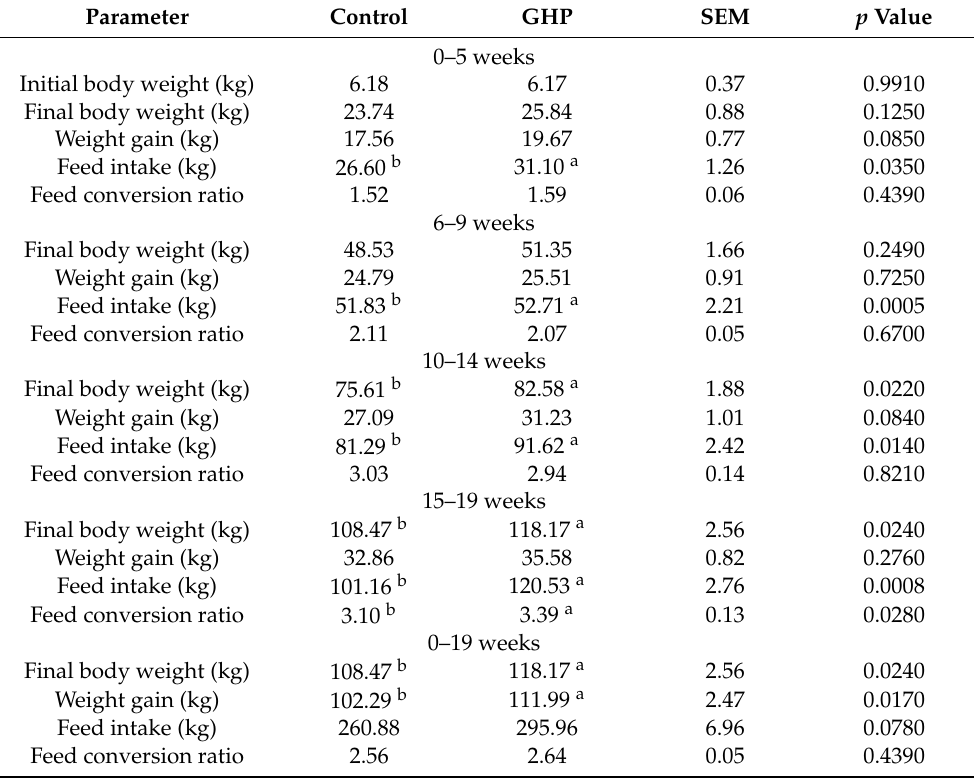
Table 5. Effect of the GHP cooling mode on the growth performance